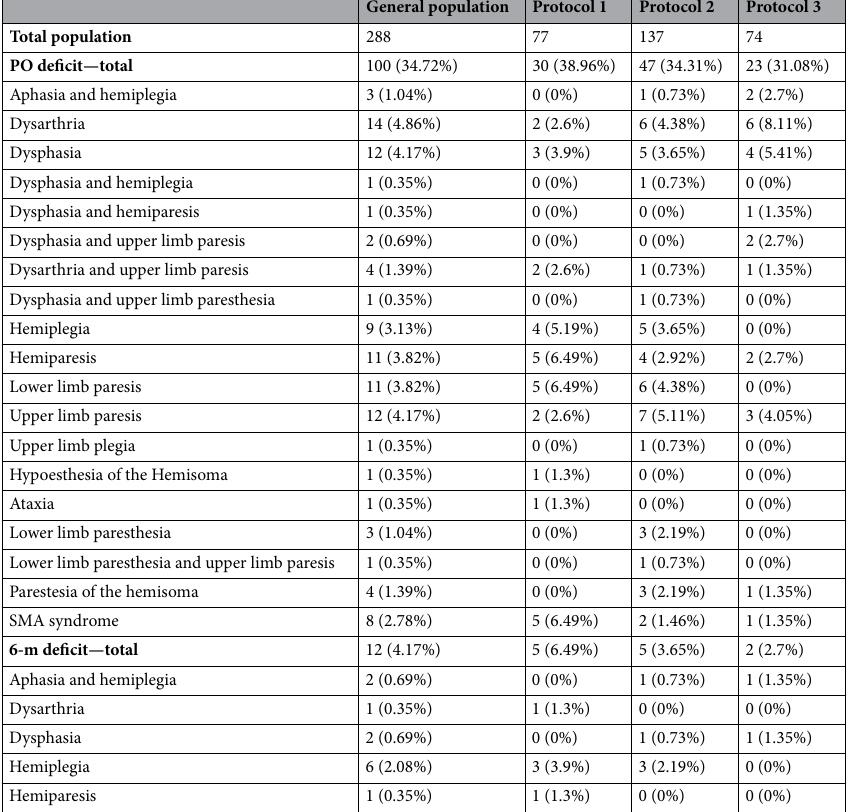
Table 2. Neurological impairment in the immediate post-operative period and 6 months after surgery in the general population and according to intraoperative protocol. Table showing the presence of neurological impairment in the immediate post-operative period and 6 months after Diffuse Low-Grade Glioma surgery in the general population and for each intraoperative Protocol. Protocol 1: Brain mapping and Direct Electrical Stimulation. Protocol 2: Protocol 1 plus overlap of functional MRI/DTI imaging on a NeuroNavigation system. Protocol 3: Protocol 2 plus Real-Time Neuropsychological Testing. PO deficit neurological deficit in the immediate Post-Operative period, 6-m deficit neurological deficit 6 months after